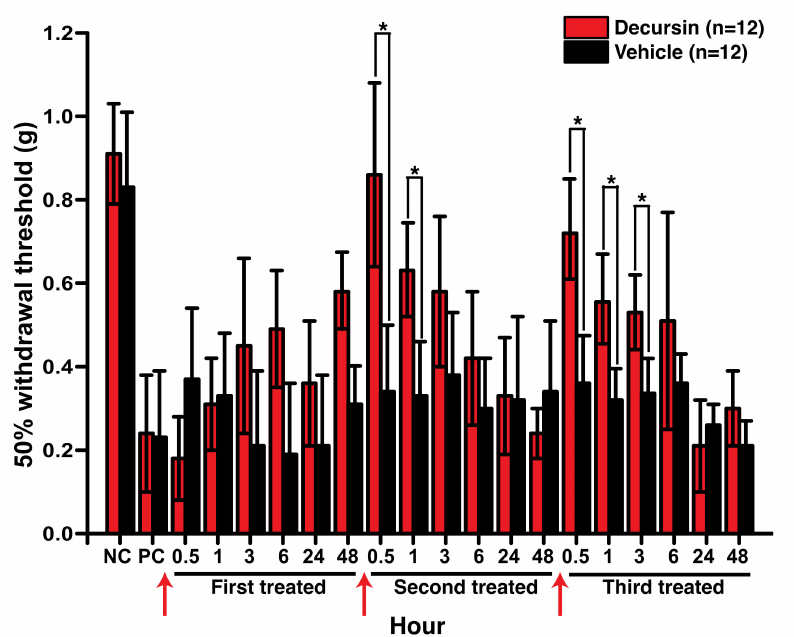
Figure 3. Effect of decursin on paclitaxel-induced neuropathic pain in mice. The mechanical allodynia test was performed immediately after injection of the vehicle and decursin. NC and PC indicate the negative control and paclitaxel-induced neuropathic pain mice, respectively. Red arrows indicate the time of decursin treatment. During the 1st, 2nd, and 3rd treatments, 50 mg/kg of decursin was administered via intrathecal injection. n indicates the number of mice in each group. * p < 0.05, determined using paired t